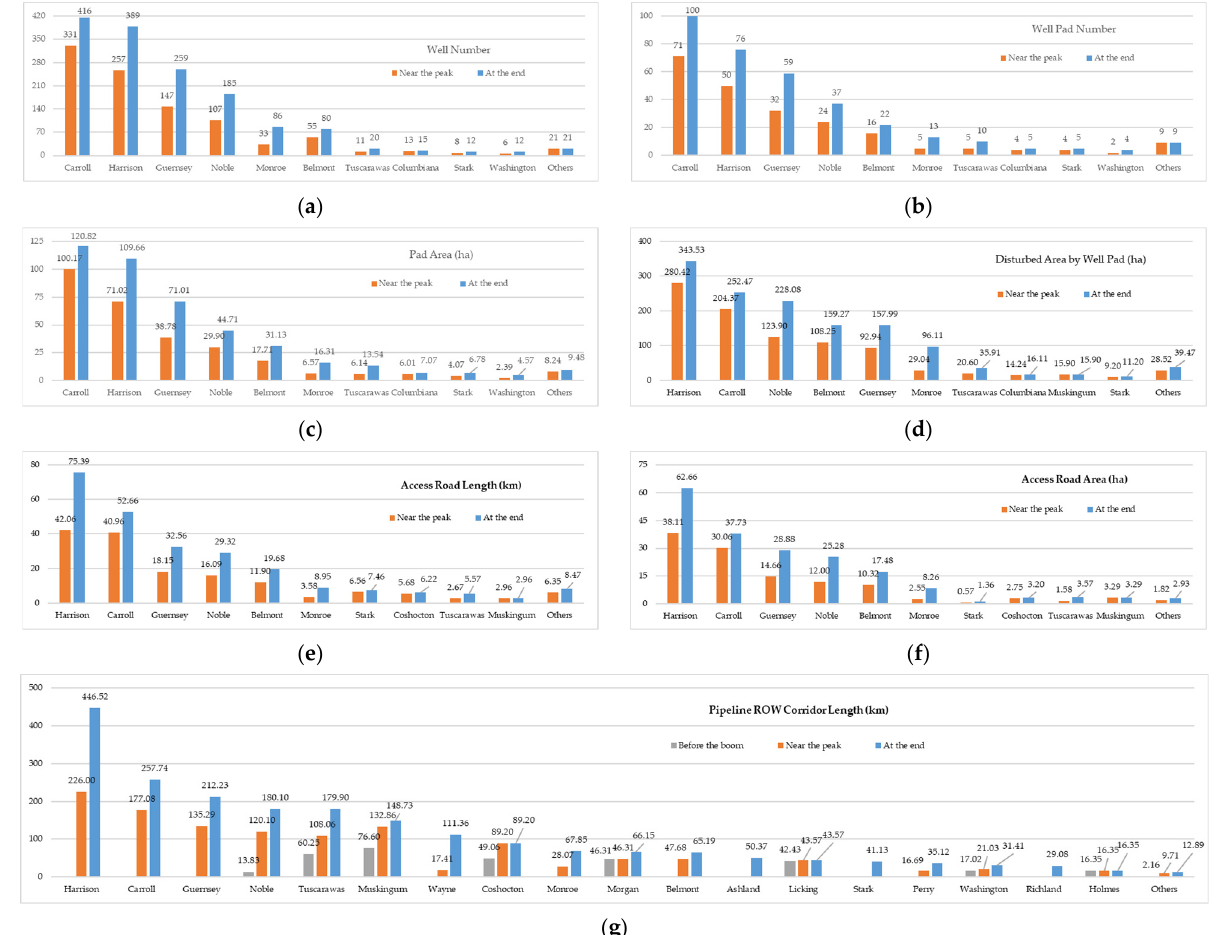
Figure 8. The development of unconventional shale gas extraction activities in the top counties near the peak and at the end of the boom: ( a ) the shale gas well number; ( b ) the well pad number; ( c ) the well pad area; ( d ) the disturbance zone area of well pads; ( e ) the length of access roads; ( f ) the area of access roads; ( g ) the length of pipeline ROW corridors.